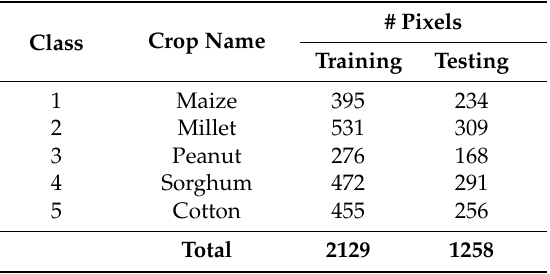
Table 4. Number of pixels per crop class for training base classifiers and assessing accuracy (testing).